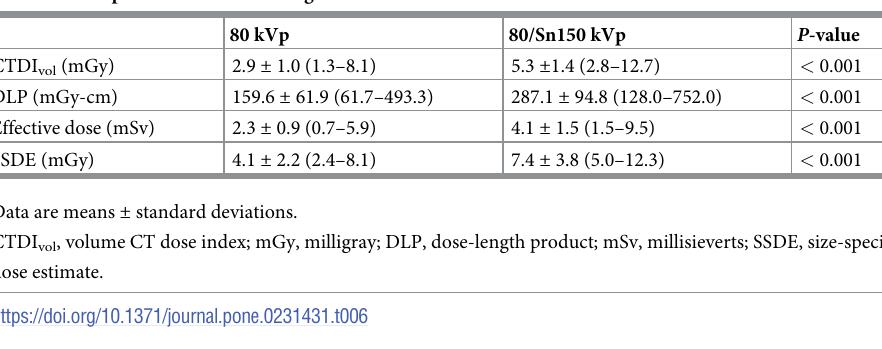
Table 6. Dose parameters of each image set.